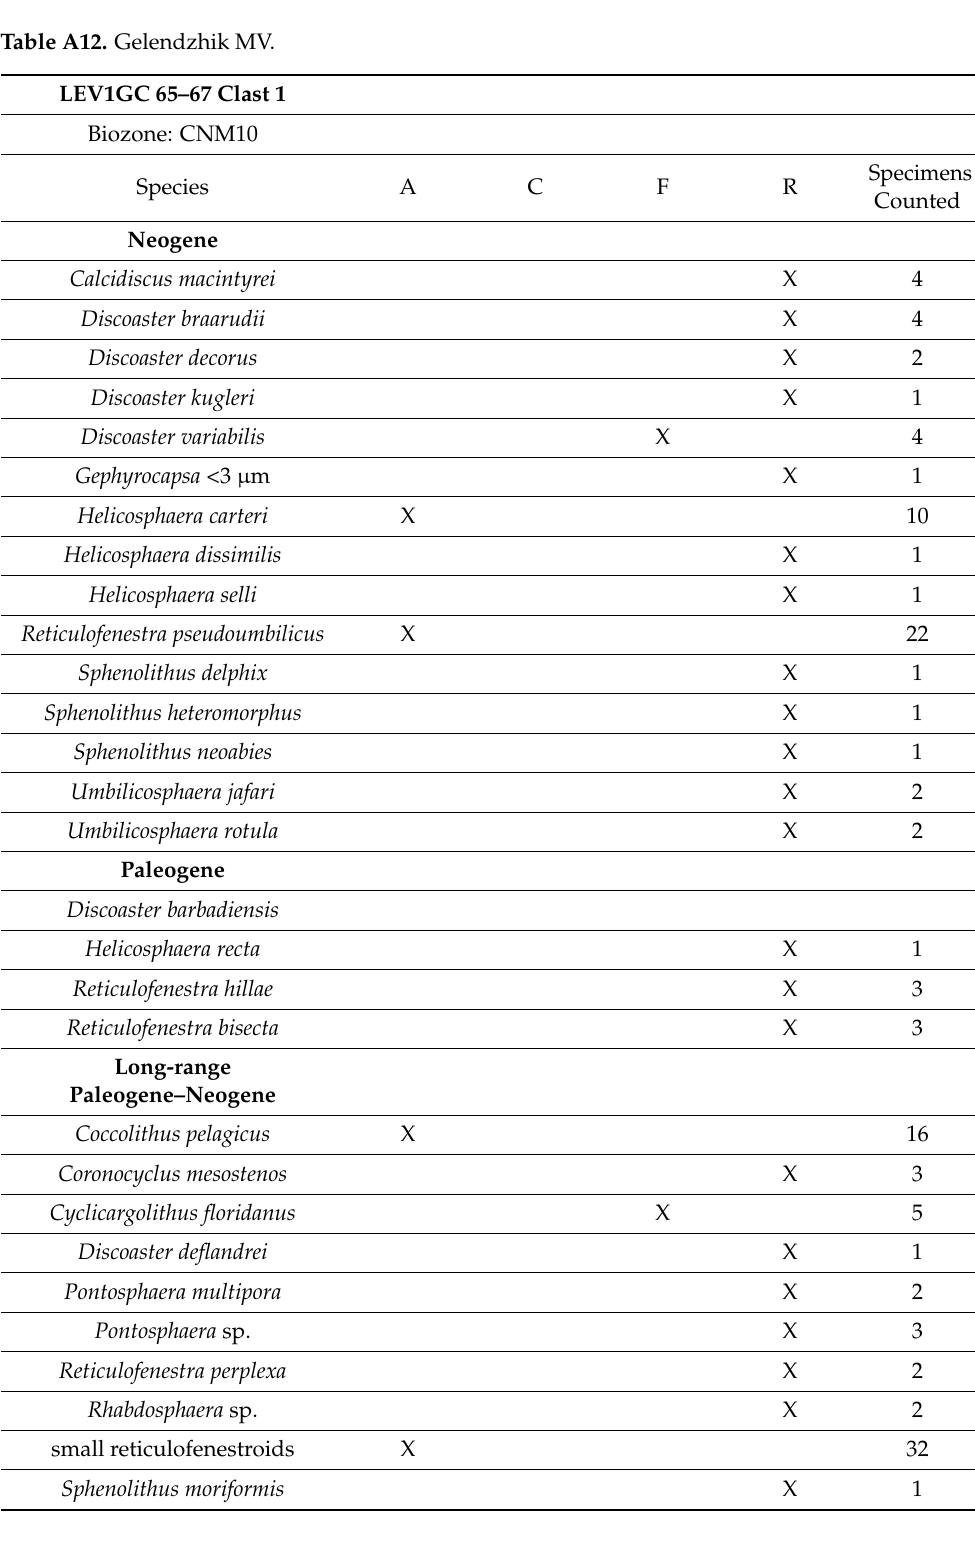
Table A12. Gelendzhik MV.